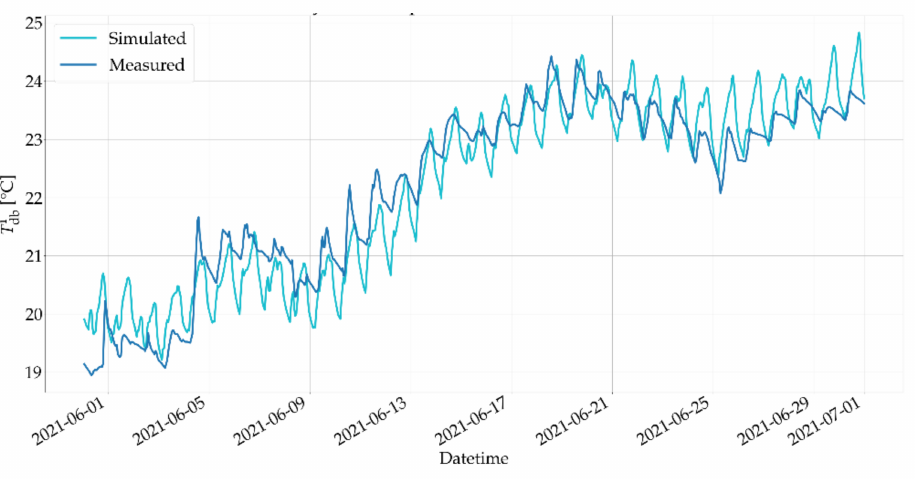
Figure 15. Indoor air temperatures simulated and measured over the considered verification time period, with optimized building